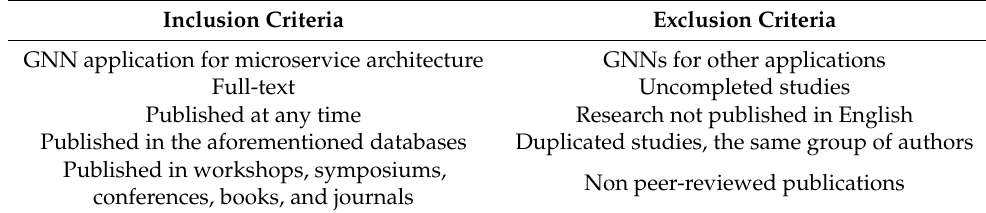
Table 2. The literature inclusion and exclusion